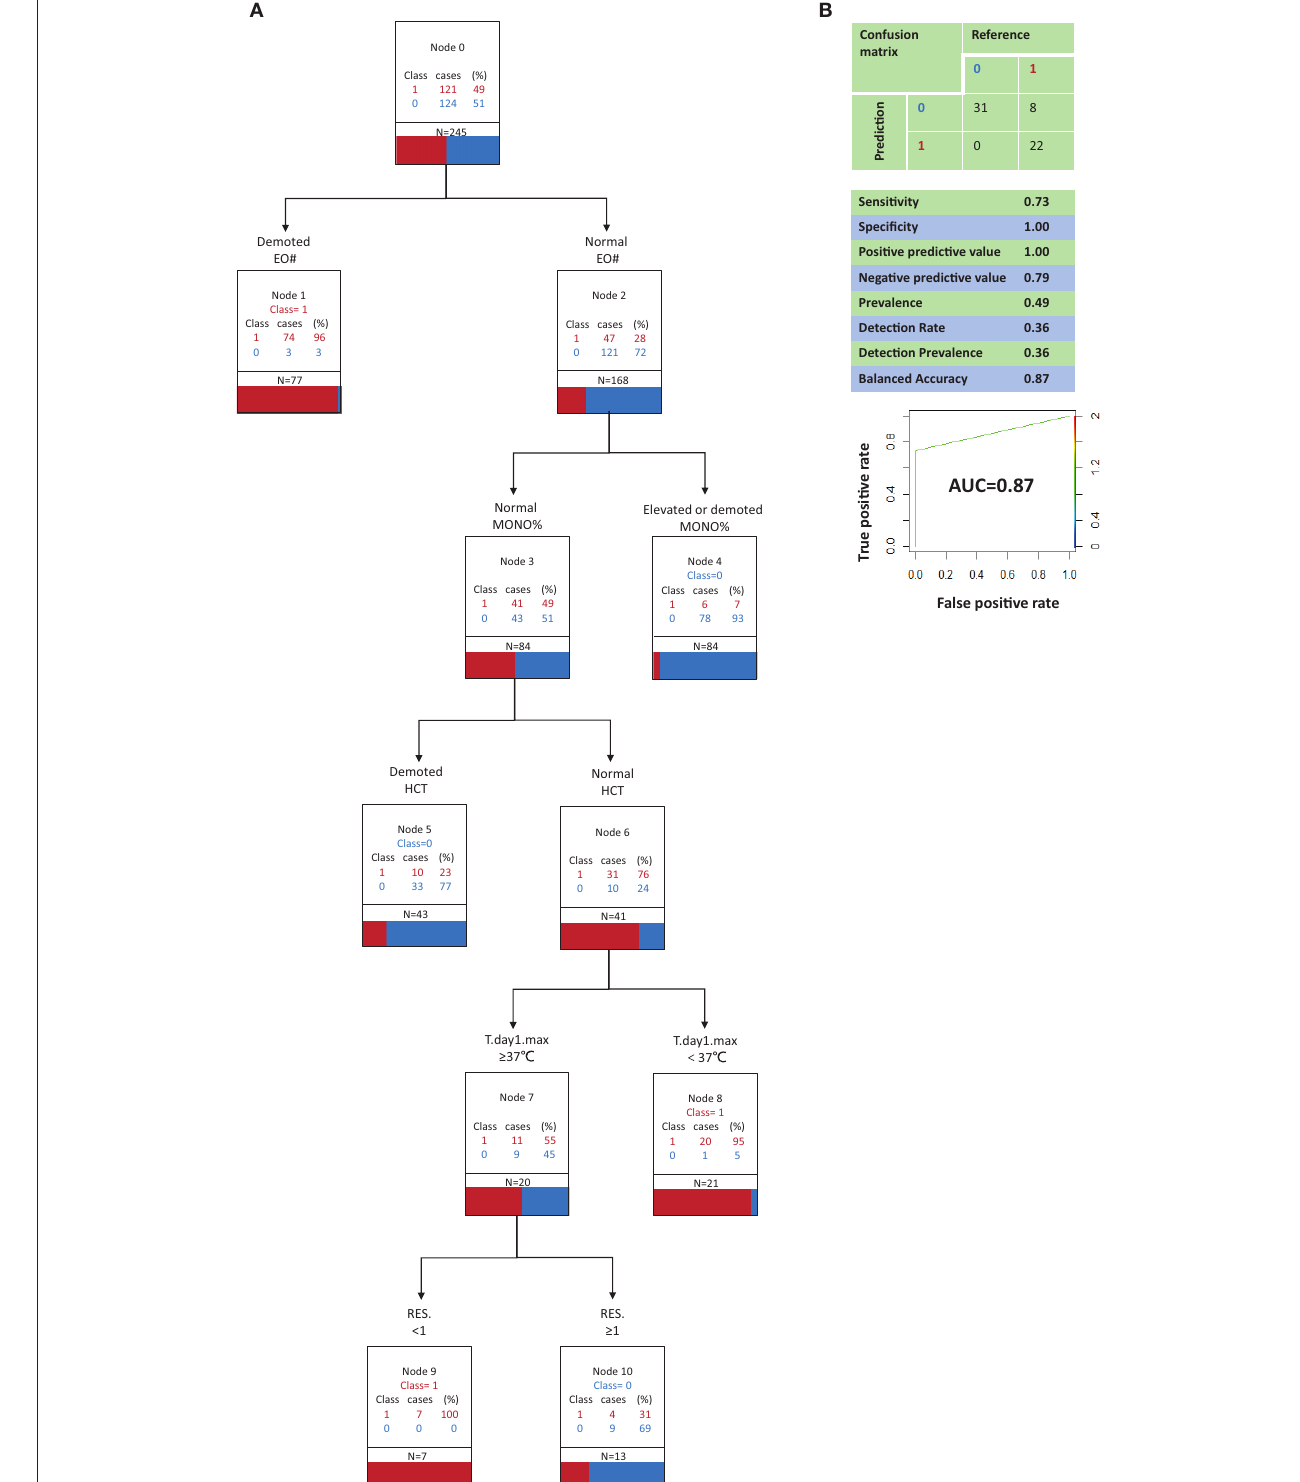
FIGURE 3 | Classification and regression tree analysis of variables that most distinguish COVID-19 from Influenza A in clinical signs and symptoms and in routine blood (model B, suboptimal model). (A) 0, Influenza A; 1, COVID-19; N , the total number of patients; RES., The number of respiratory symptoms; T.day1.max, Highest temperature on the first day of admission; EO#, eosinophil count; MONO%, monocyte ratio; HCT, Hematocrit. All factors are compared with the limit of the range of medical reference value. (B) Performance characteristics of the model validated by the testing set.